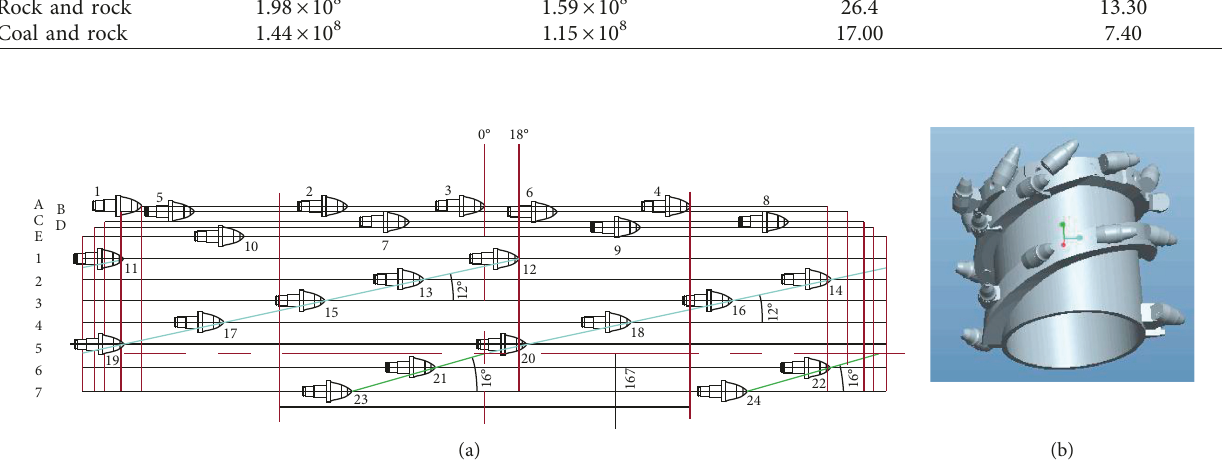
Figure 2: (a) The picking arrangement diagram of the drum (b) Three-dimensional model of the drum.